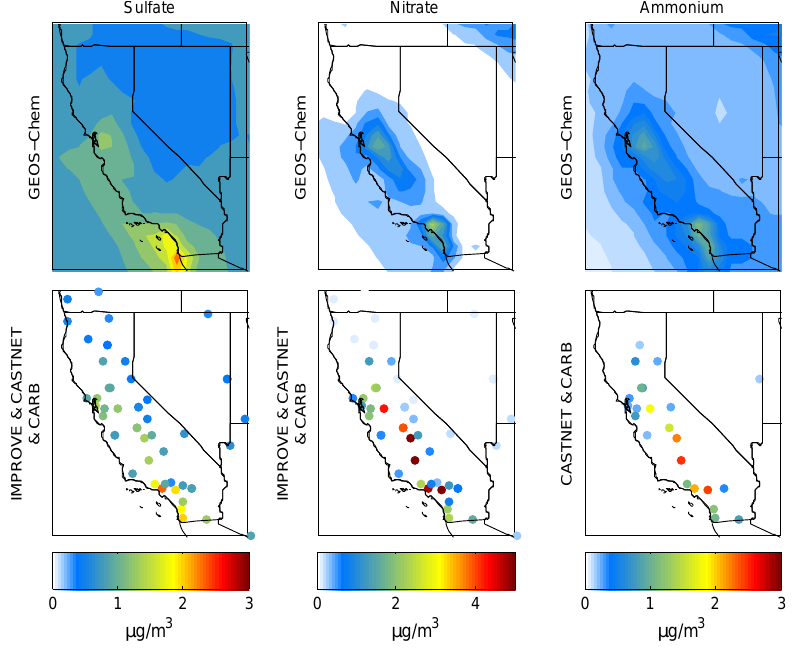
Fig. 5. Same as Fig. 4, but in detail for California.